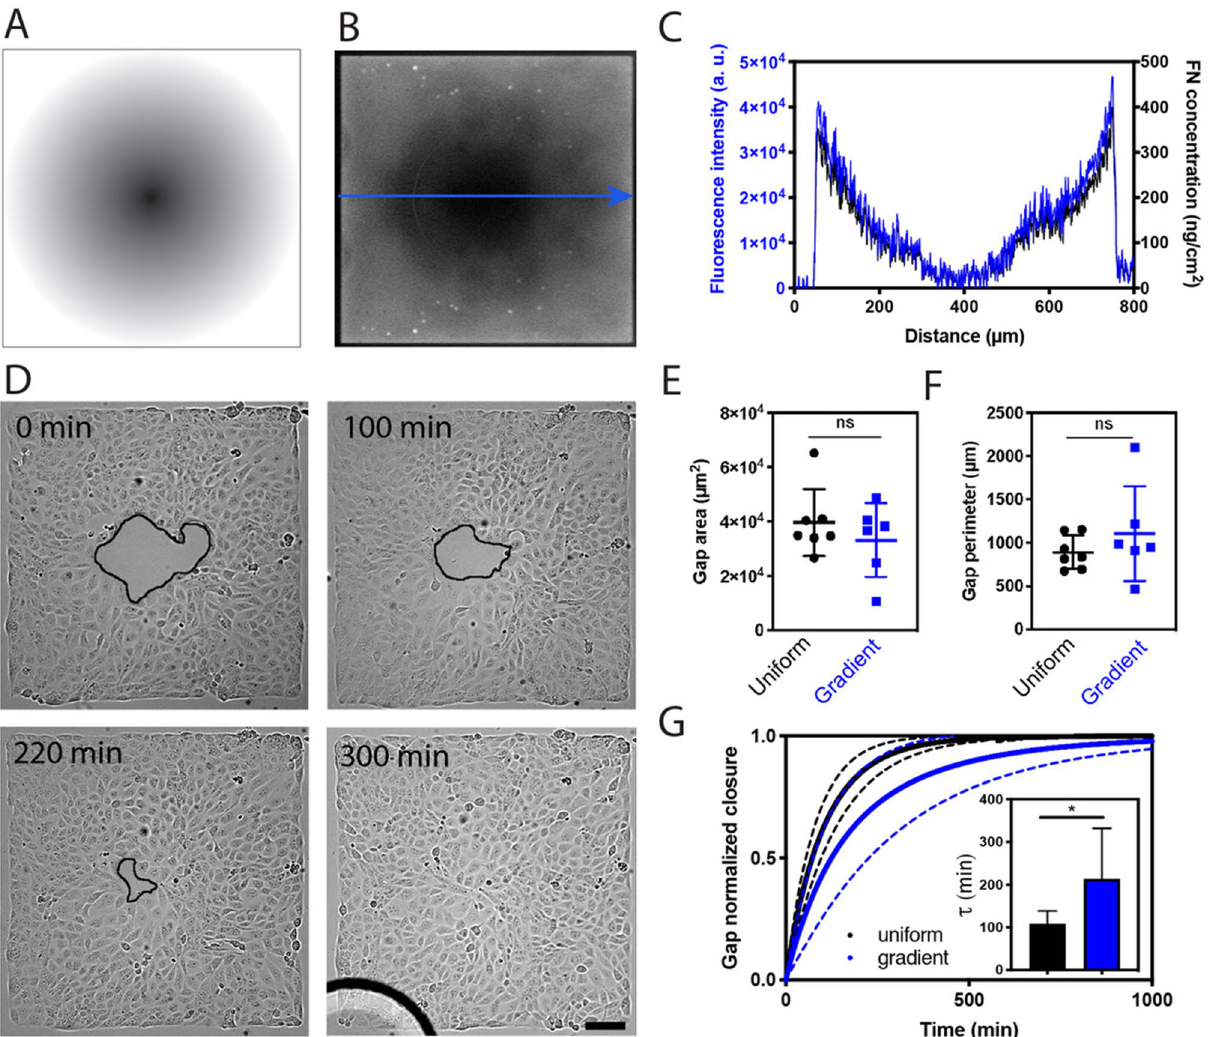
Figure 1. Epithelial gaps closure is slowed down on a FN gradient compared to on homogeneously coated substrates. ( A ) Design of the photopattern used to create a centered circular gradient of FN (gradient of gray) within a square FN pattern (in white) of 764 µm wide. ( B ) Epifluorescent image of a FN gradient labelled with rhodamine. ( C ) Plot profile of the fluorescence intensity (left axis) and the surface density (right axis) of the rhodamine-conjugated FN according to the blue arrow. Low fluorescence intensity values at both extremities correspond to the black frame of ( B ). ( D ) Time-lapse images in DIC mode of a gap closure in a confluent epithelium grown on a circular FN gradient. The edge of the closing gap was highlighted with a black line. Scale bar, 100 µm. Distribution of ( E ) the gap area and ( F ) the gap perimeter in confluent epithelia grown on a uniform coating (in black) or a gradient (in blue) of FN. ( G ) Temporal evolution of the mean normalized gap area during the closure on a uniform coating (in black, n = 7) or a gradient (in blue, n = 6) of FN. Full lines represent the mean and dashed lines the